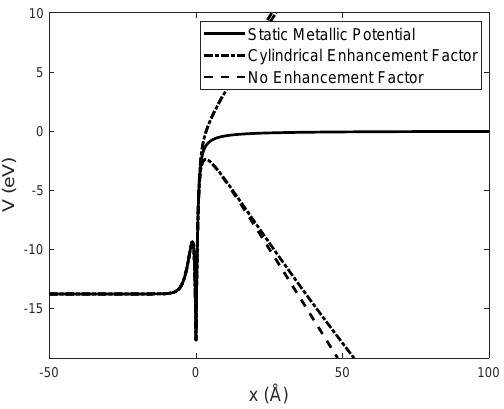
Figure 2. Electrostatic potential, V jellium ( x ) + V s ( x ) , with and without external fields applied. The ground state electron is largely bounded to the surface atomic potential.